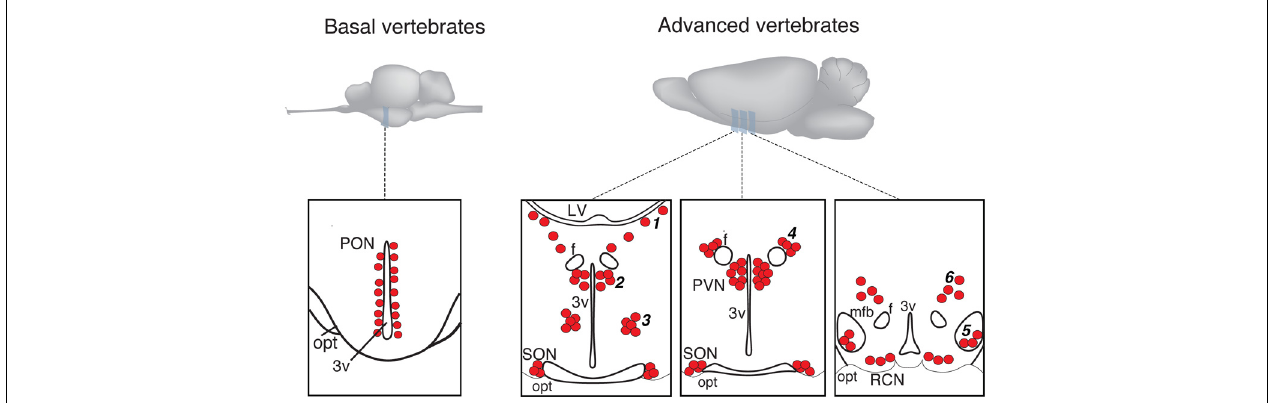
FIGURE 1 | Schematic presentation of magnocellular hypothalamic nuclei in representative examples of basal and advanced vertebrates (drawings are based on Grinevich and Polenov, 1994). 3v, third ventricle; F, columns of fornix; LV, lateral ventricle; MFB, medial forebrain bundle; OC,